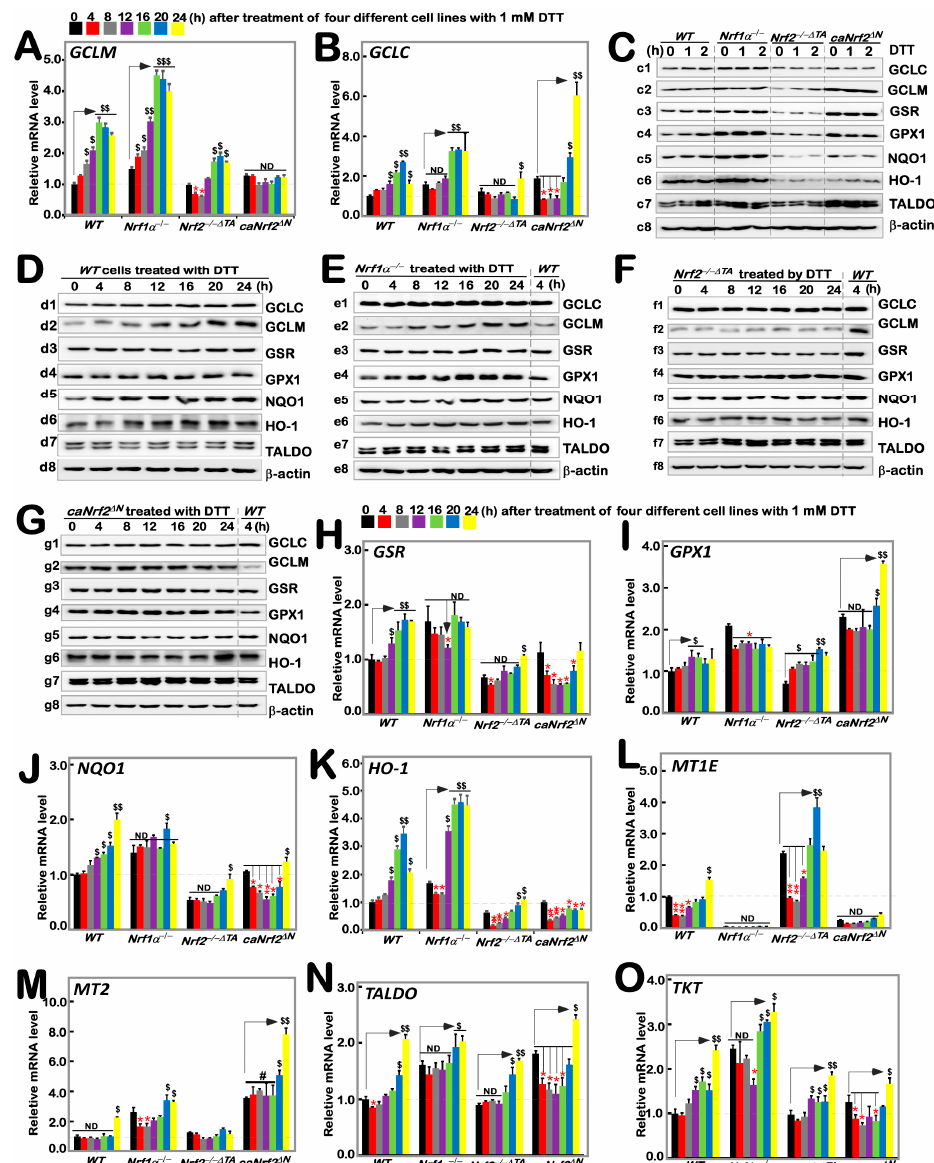
Figure 2. Distinct time-dependent expression of Nrf1/2-mediated redox response genes to DTT in different cell lines. Different genotypic cell lines WT , Nrf1 α − / − , Nrf2 − / − △ TA and caNrf2 △ N were or were not treated with 1 mM DTT for 0 to 24 h, before both basal and DTT-inducible mRNA levels of all examined genes were determined by RT-qPCR. These genes included GCLM ( A ), GCLC ( B ), GSR ( H ), GPX1 ( I ), NQO1 ( J ), HO-1 ( K ), MT1E ( L ), MT2 ( M ), TALDO ( N ) and TKT ( O ). The resulting data were shown as fold changes ( mean ± SD , n = 3 × 3 ), which are representative of at least three independent experiments being each performed in triplicate. Signifi- cant increases ( $ , p < 0.05 ; $$ , p < 0.01 ) and significant decreases ( * p < 0.05 ; ** p < 0.01 ), in addition to the non-significance (ND), were